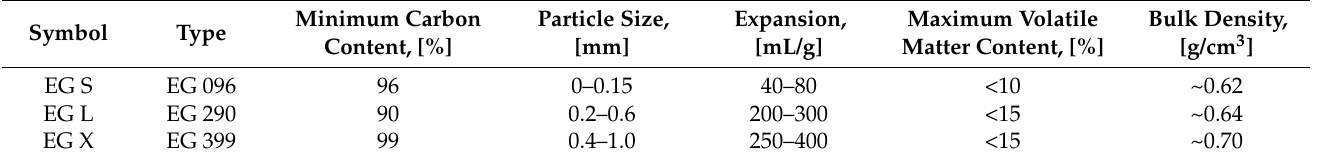
Table 2. Characteristics of expanded graphite (EG).